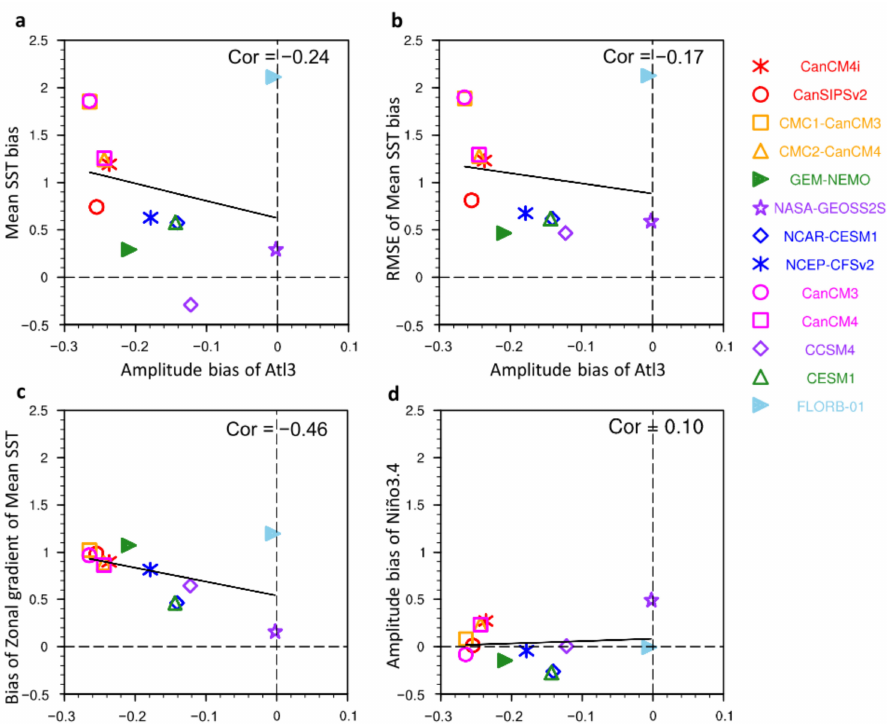
Figure 12. Same as Figure 11, except for five-month-lead